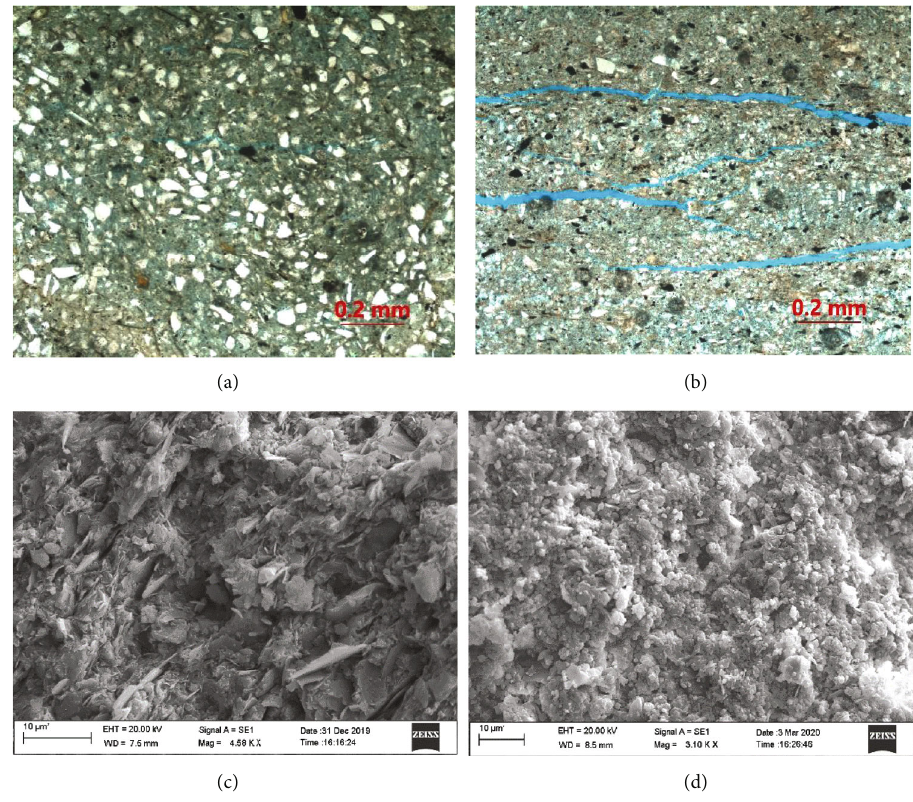
Figure 1: Reservoir space types of the III+IV oil group in Nanyishan Oil fi eld. (a) 1# Stucco siltstone, micropore fracture. (b) 2# Sandy mudstone, intergranular pore fracture. (c) 3# Calcareous mudstone, micropore fracture. (d) 5# Silty mudstone, micropore-dissolution pore.